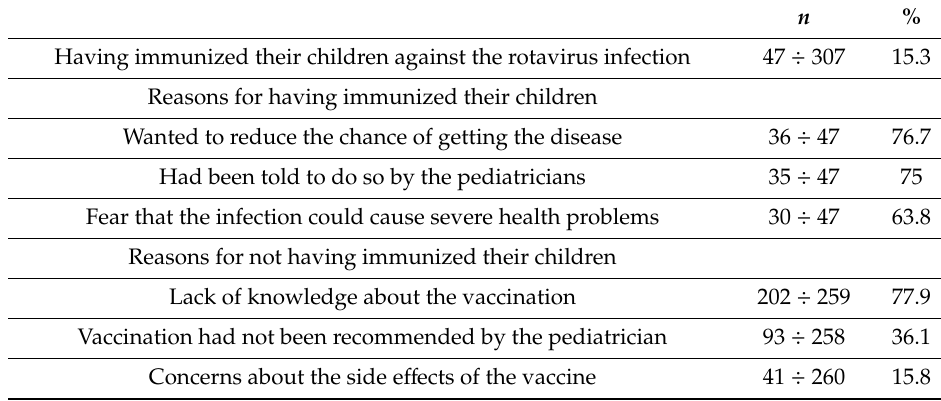
Table 5. Behaviors about rotavirus vaccination of the study respondents. n % Having immunized their children against the rotavirus infection 47 ÷ 307 15.3 Reasons for having immunized their children Wanted to reduce the chance of getting the disease 36 ÷ 47 76.7 Had been told to do so by the pediatricians 35 ÷ 47 75 Fear that the infection could cause severe health problems 30 ÷ 47 63.8 Reasons for not having immunized their children Lack of knowledge about the vaccination 202 ÷ 259 77.9 Vaccination had not been recommended by the pediatrician 93 ÷ 258 36.1 Concerns about the side e ff ects of the vaccine 41 ÷ 260